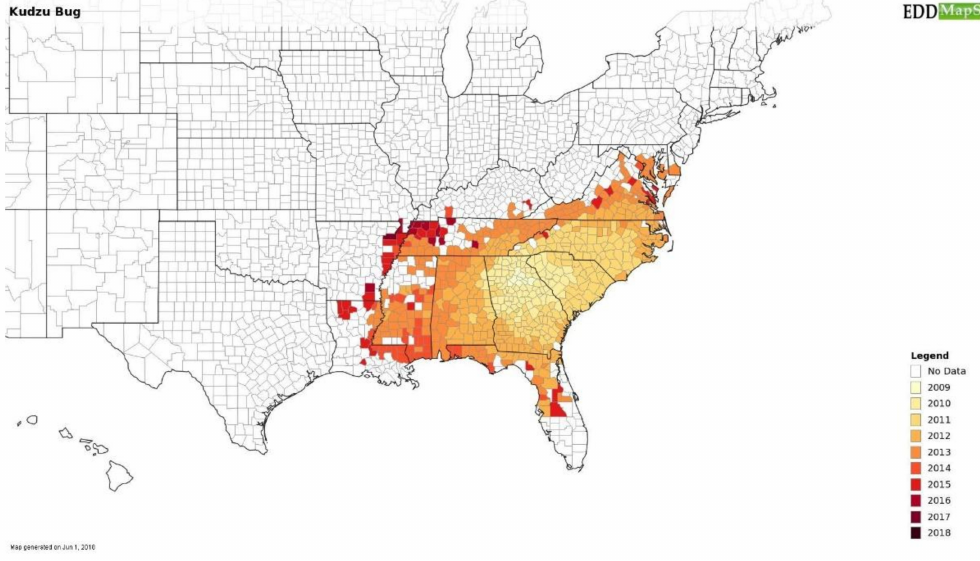
Figure 4. Change over time in the introduction and spread of kudzu bug ( Megacopta cribraria ( F